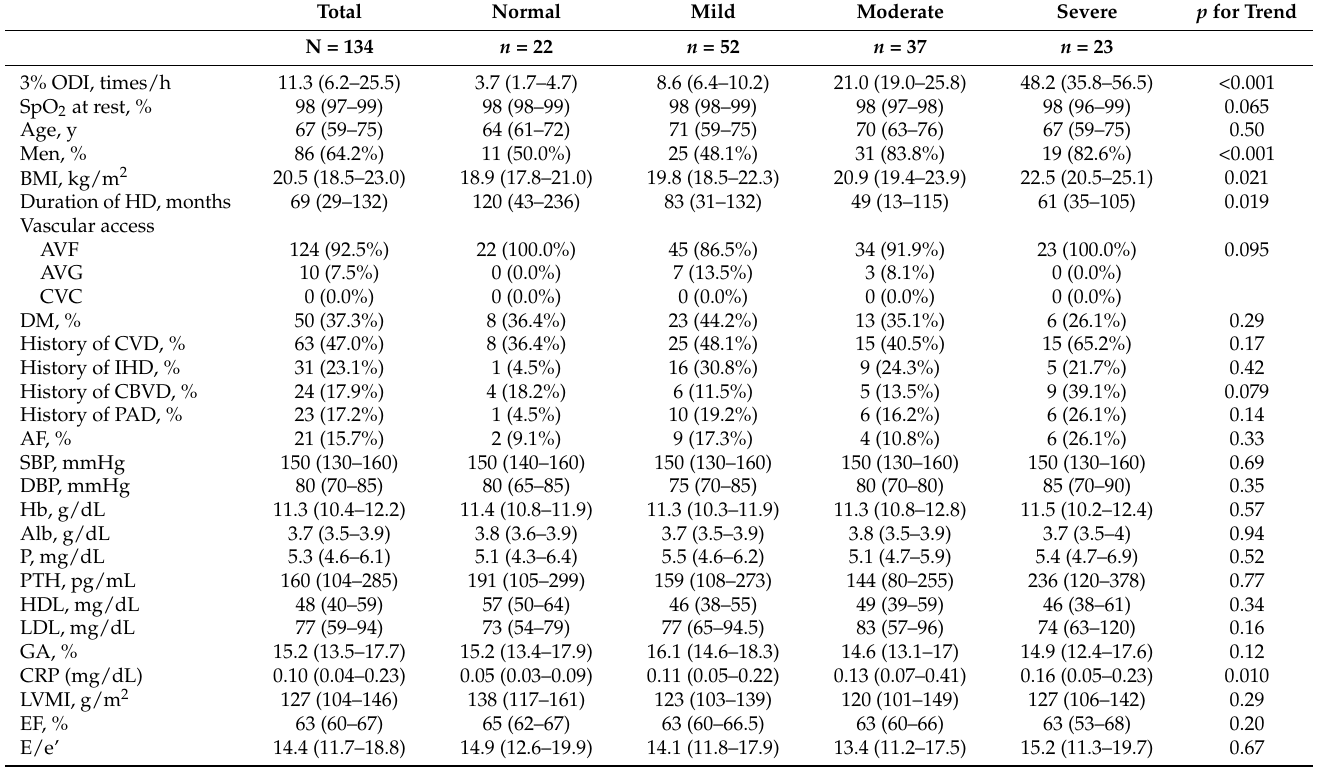
Table 1. Baseline characteristics of patients according to SDB